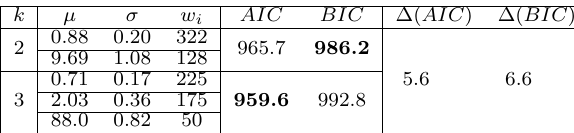
Figure 4. The AIC and BIC values as a function of the number of Gaussian components used to fit the density of exoplanets. AIC shows a preference for two components, whereas BIC shows a preference for three. TABLE 1 Model Comparison parameters for exoplanets, when classified according to density. The first column denotes the number of components used for the fitting. The second column is the best-fit value for the logarithm of the density (expressed in gm / cm 3 ), the third column is its standard deviation, and the fourth column indicates the number of planets classified in each category. The next two columns indicate the AIC and BIC value for both the hypothesis. The last two columns indicate the absolute value of ∆ (AIC/BIC) between the model with minimum value and the next highest value. As we can see, AIC prefers 3 components, whereas BIC prefers 2. However, ∆ AIC and ∆ BIC are both < 10 and hence their significance (compared to the value with higher AIC/BIC) is